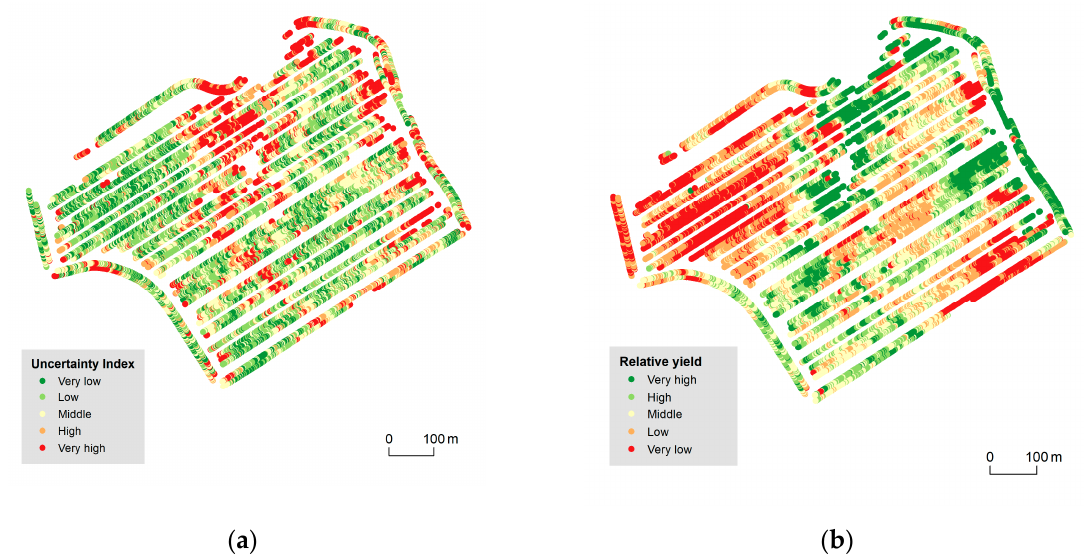
Figure 7. The extended traffic light metaphor for qualitative data on uncertainty ( a ) and yield ( b ) for Pivovárka plot.